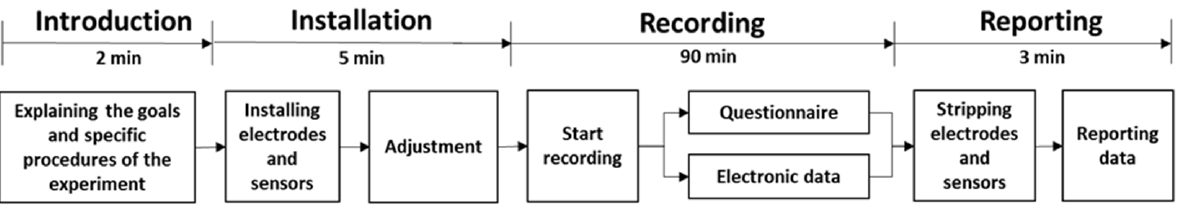
Figure 3. Process and timeline of assessments.